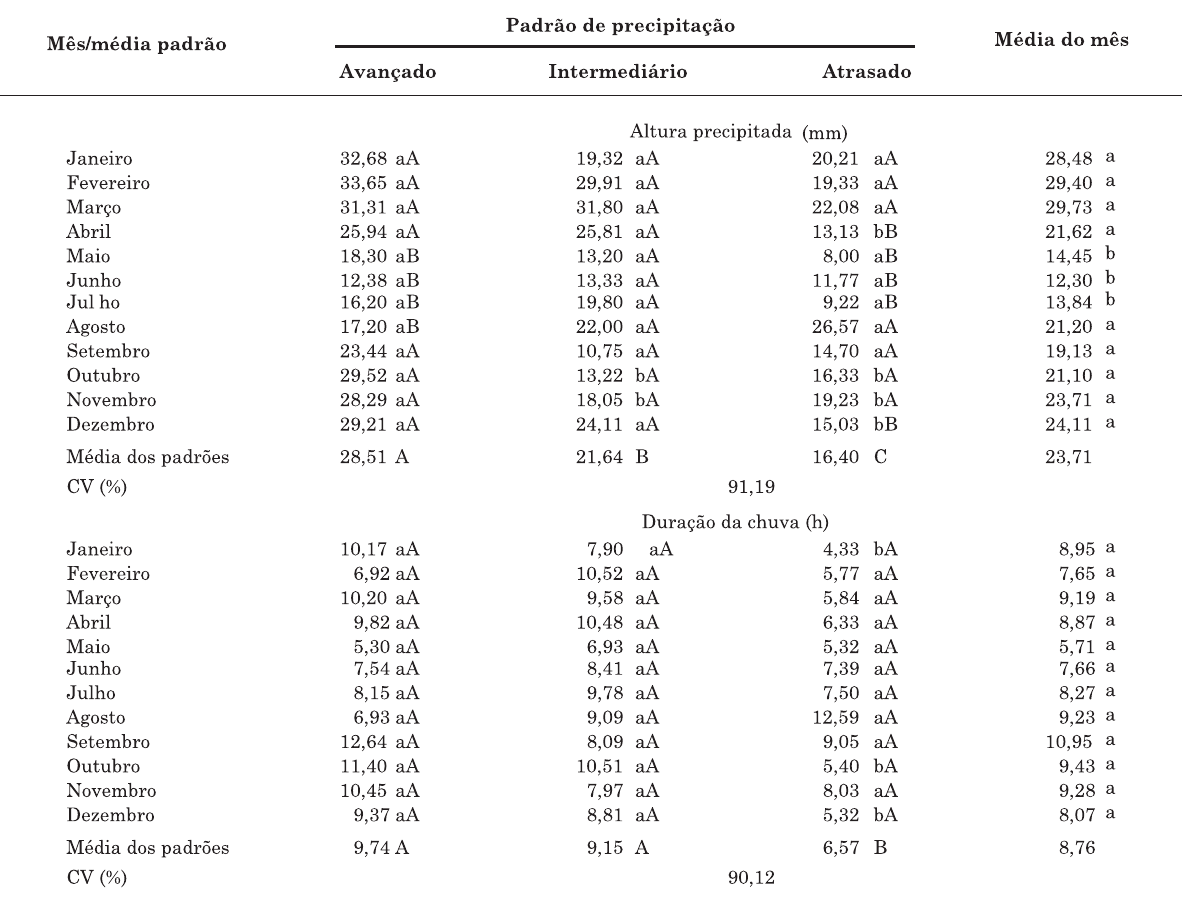
Quadro 2. Altura precipitada e duração das chuvas para os diferentes padrões de precipitação pluvial ao longo do ano em Ribeirão das Lajes